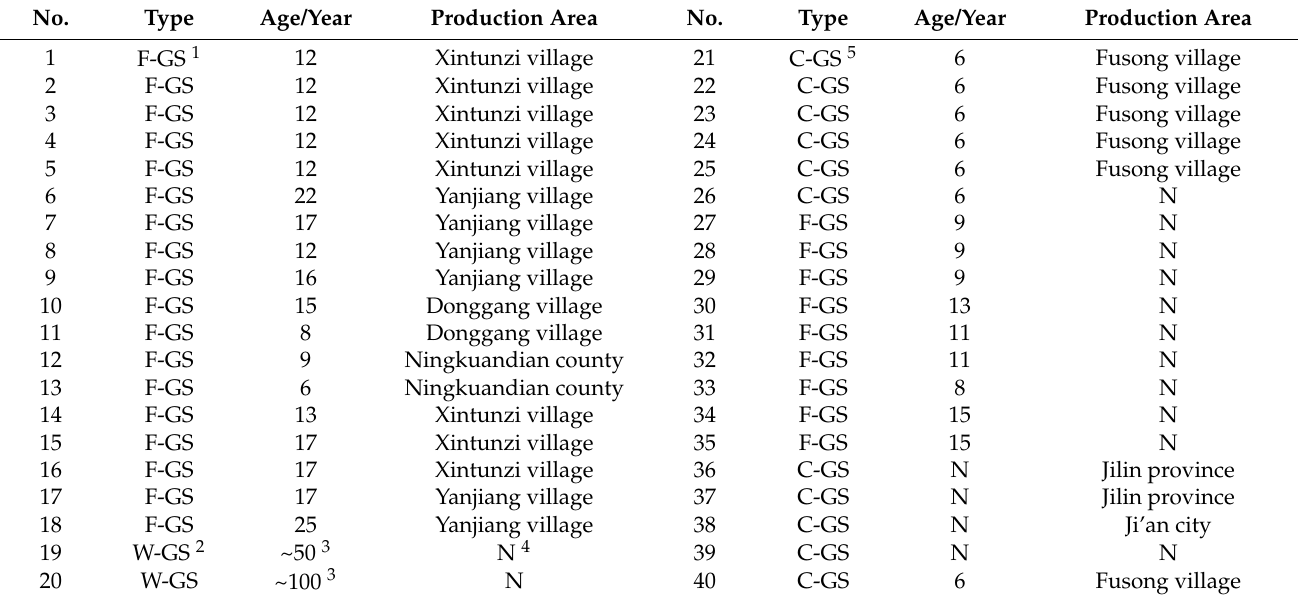
Table 8. Detail information of forty ginseng samples used in the present